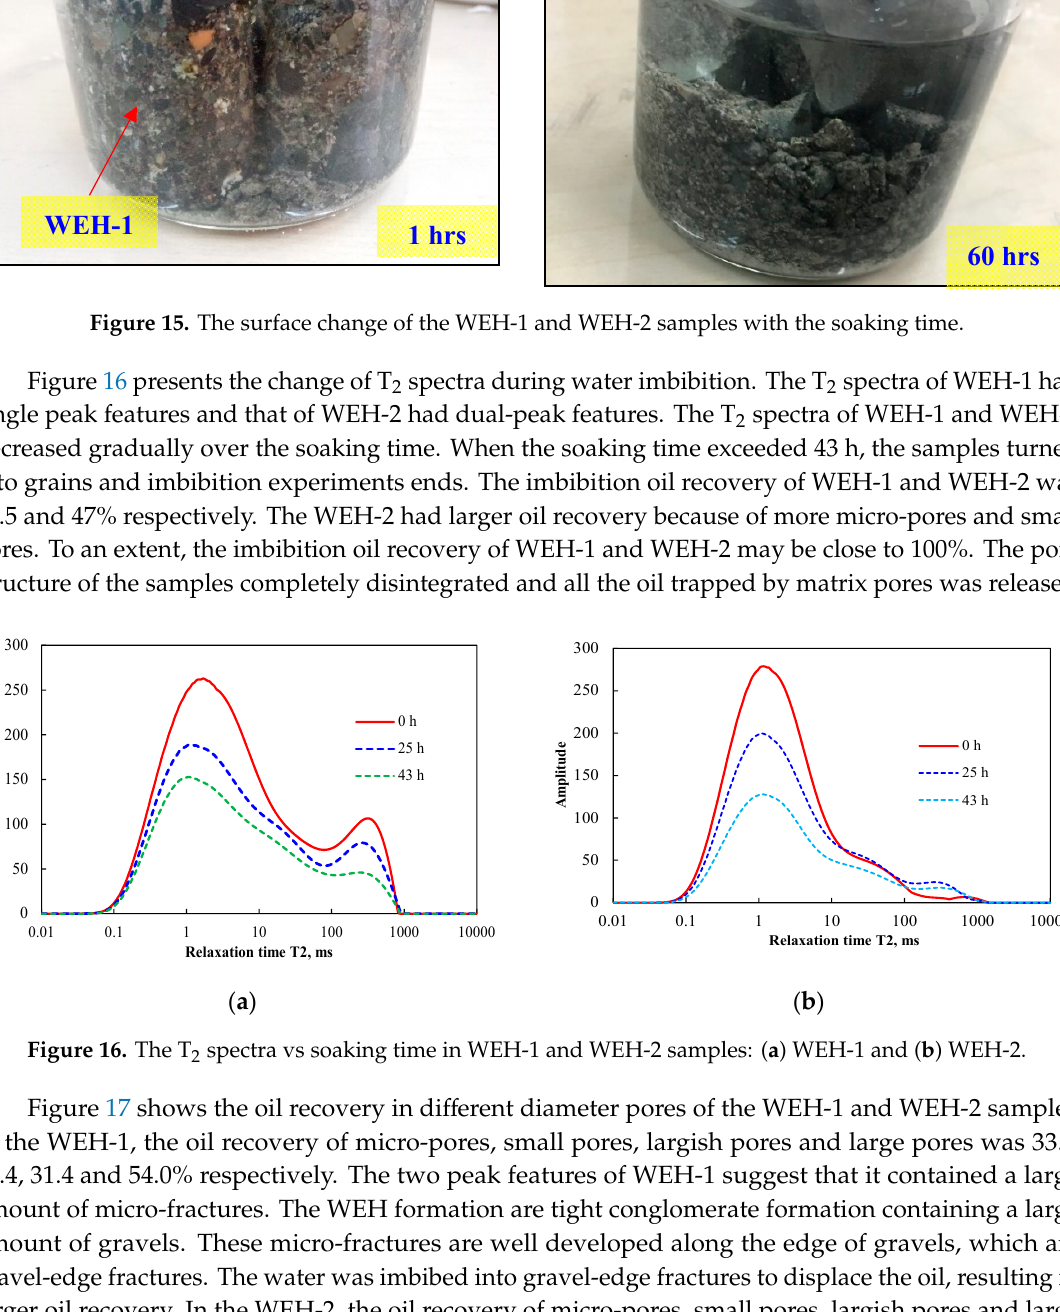
Figure 14. Oil recovery in different diameter pores: ( a ) QT-1 and ( b ) QT-2.